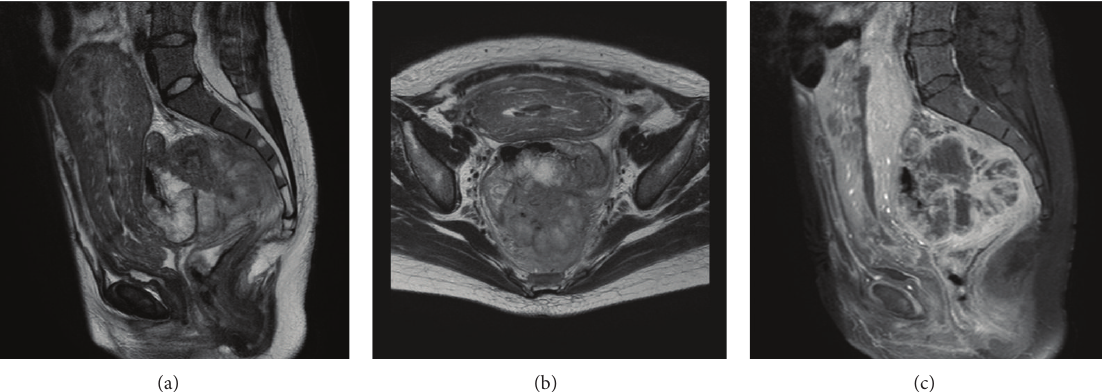
Figure 2: Magnetic resonance imaging (MRI) of the pelvic tumor revealed a mass measuring approximately 5cm, behind the rectum ((a) T2 enhanced sagittal, (b) T2 enhanced axial, and (c) contrast enhanced spectral inversion recovery (CE SPIR) sagittal). The inside of this mass was stained heterogeneously with contrast medium, and the lymph nodes around the tumor were swollen. The tumor was diagnosed as rectal cancer.